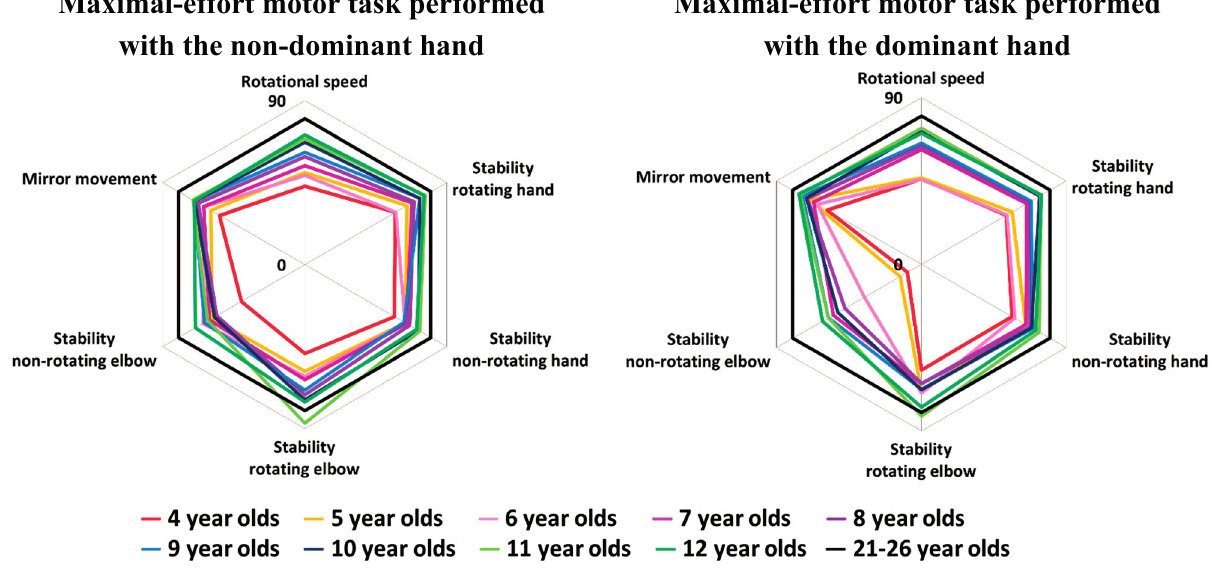
Figure 7. Radar charts for all